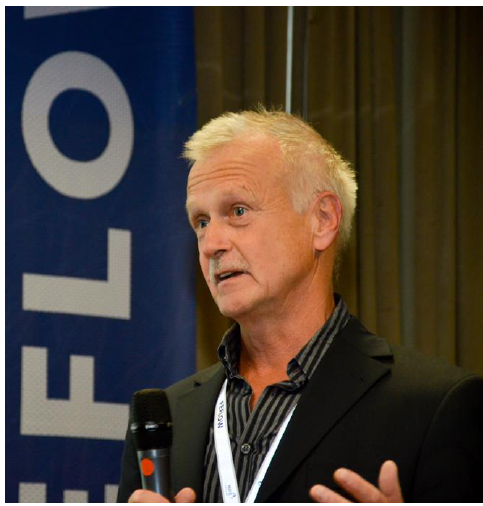
Figure A3. Hans-Jörg G. Diersch.